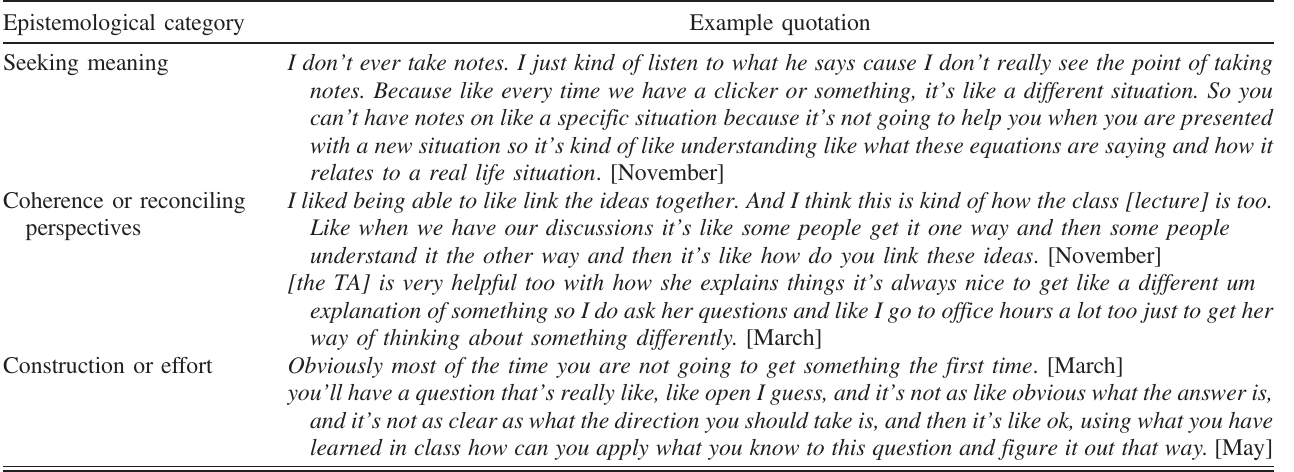
TABLE I. Phillip ’ s framing aligns with the epistemological aims of the reformed physics course. Epistemological